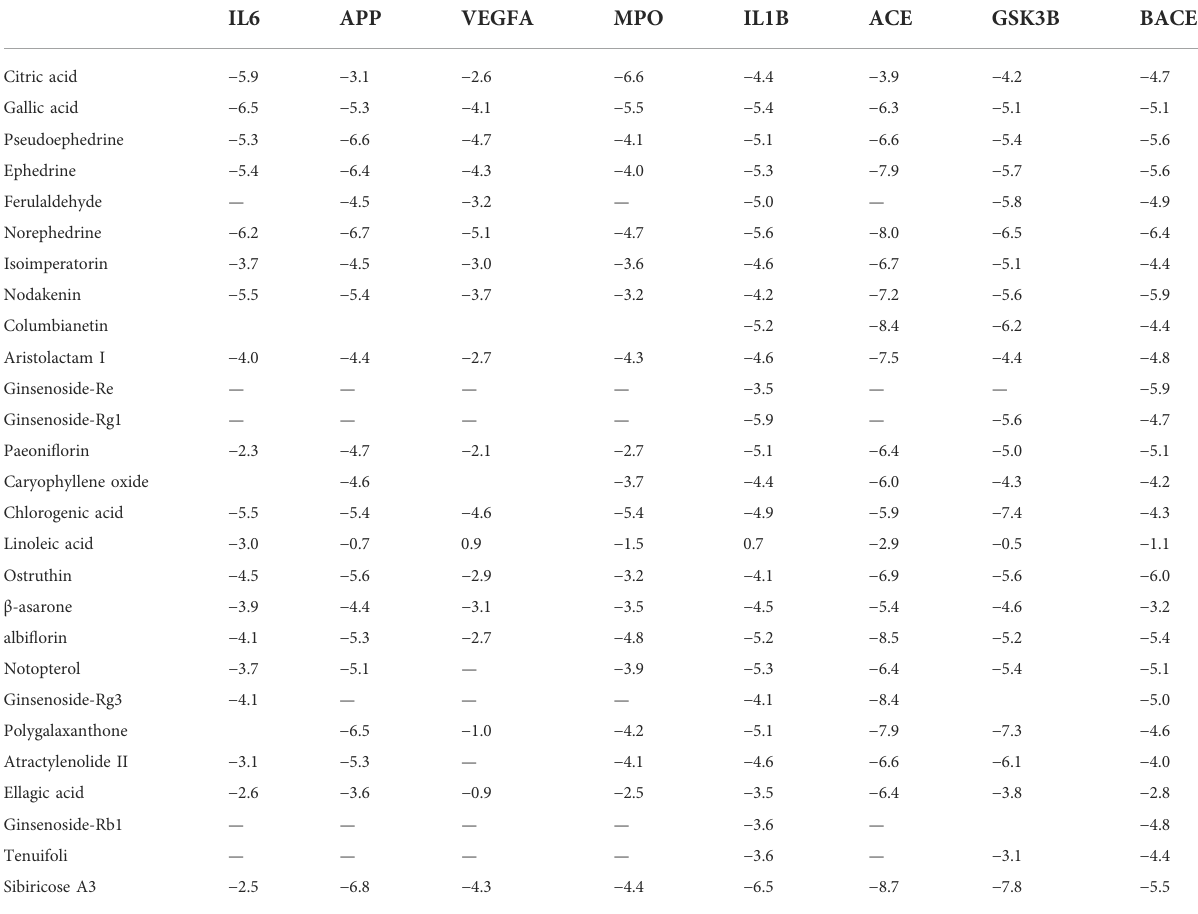
TABLE 5 The docking information of 8 targets with 27 compounds of